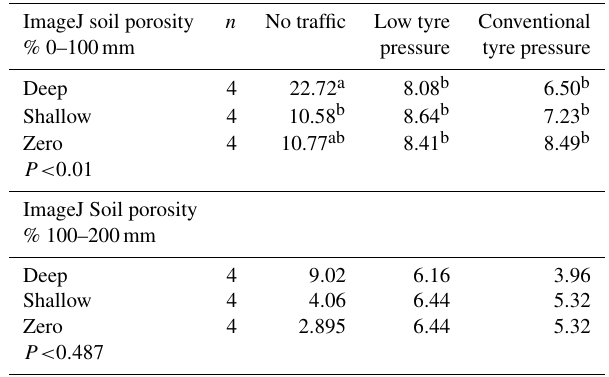
Table 4. Soil porosity for tillage × traffic for two soil